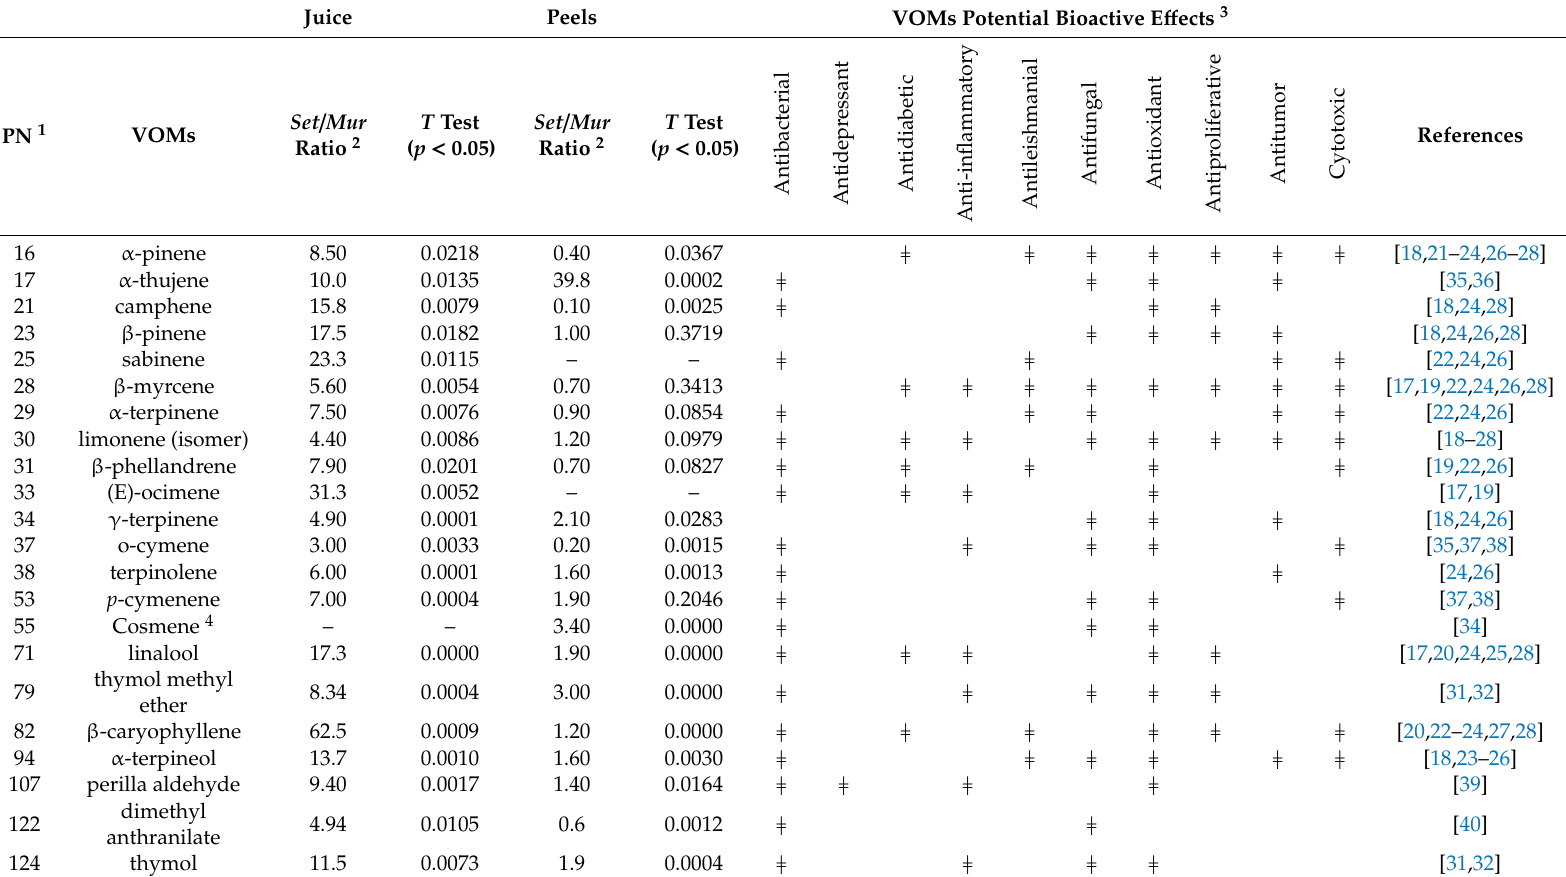
Legend: 1 VOMs peak number in the chromatograms (Figure 1); 2 ratio between the relative peak areas obtained for setubalense and murcott tangerines; 3 potential bioactive e ff ect indicates the type of bioactive e ff ects reported for each of the VOMs referred in the table, mur — murcott cultivar, set—setubalense cultivar; 4 strong evidence for the indicated bioactivity, } reported bioactive e ff